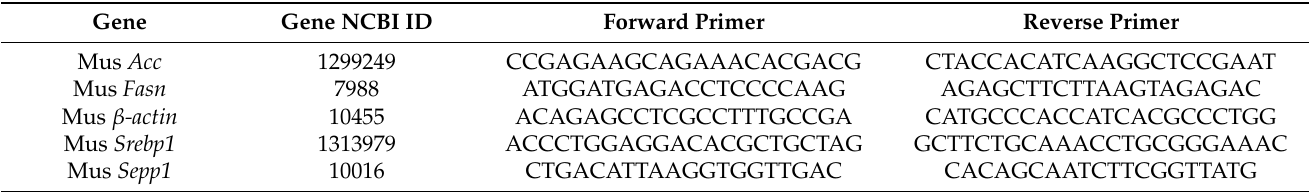
Table 1. Primers for real-time PCR